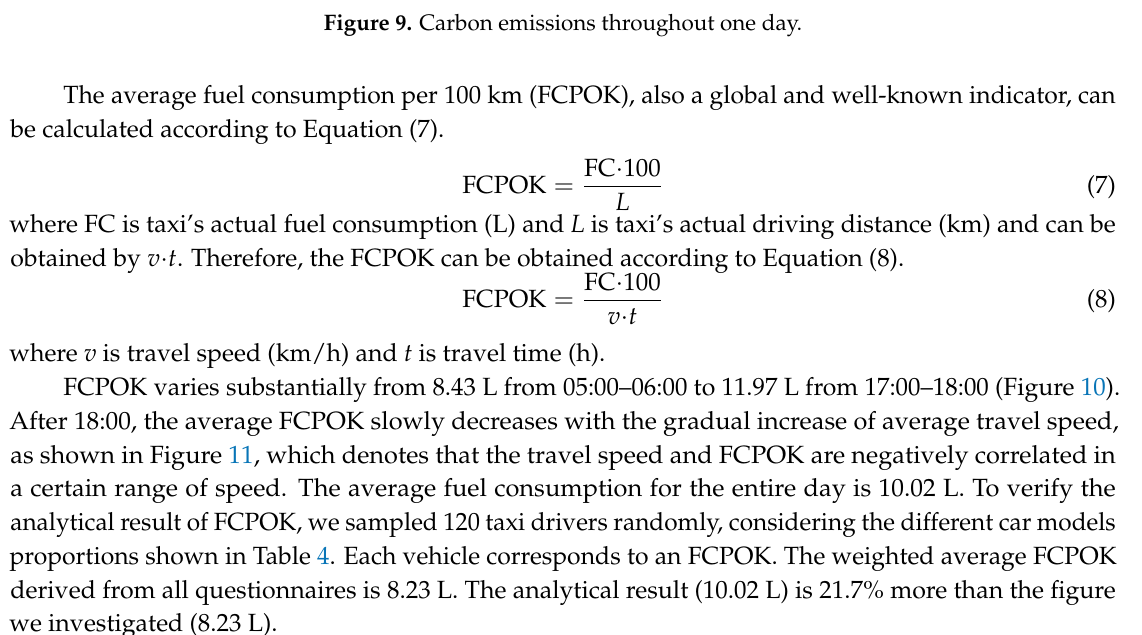
Figure 9. Carbon emissions throughout one day.